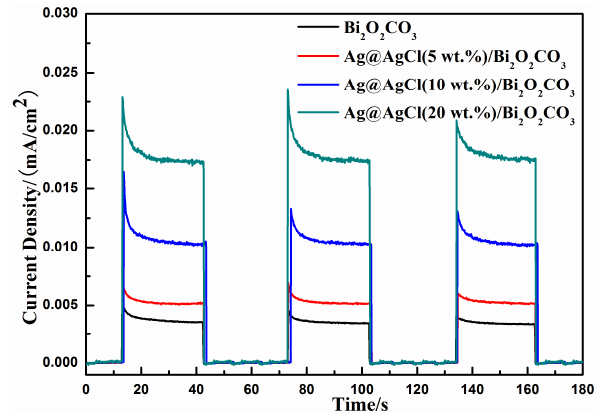
Figure 11. Transient photocurrent response for the pure Bi 2 O 2 CO 3 , Ag@AgCl (5 wt %)/Bi 2 O 2 CO